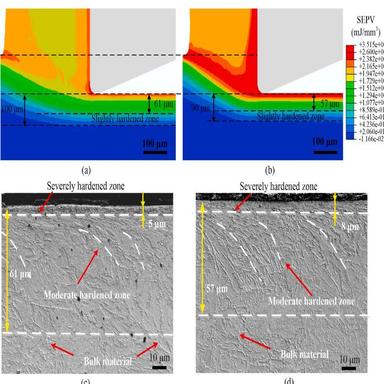
Simulation and experimental results of hardened zone near the machined surface. (a) and (b) present the simulation results of SEPV fields at 30 m/min and 150 m/min (c) and (d) present the SEM images of the hardened zones corresponding to (a) and (b).